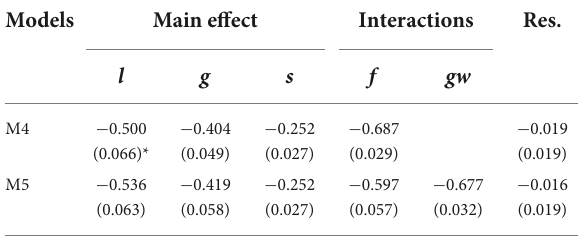
TABLE 6 Between-trait correlations for model effects of multi-trait models (M4 and